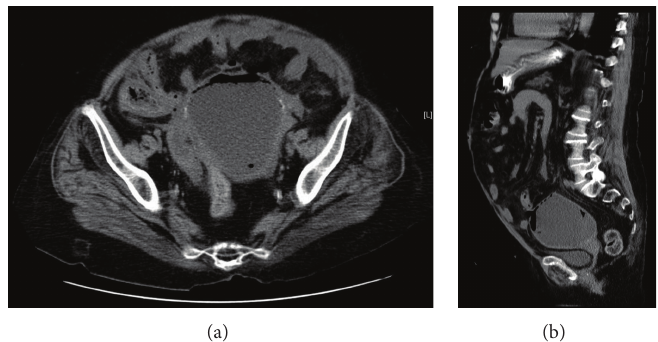
Figure2:Transverse(a)andsagittal(b)viewsofnoncontrasted-enhancedcomputedtomography(CT)scanshowingasignificantlydistended fluid-filled uterus measuring 10 × 7.8 × 10cm, in addition to a single focus of perforation involving the uterine fundus and associated with presence of free air within the nondependant area. No evidence of ascites or pelvi-abdominal lymphadenopathy was